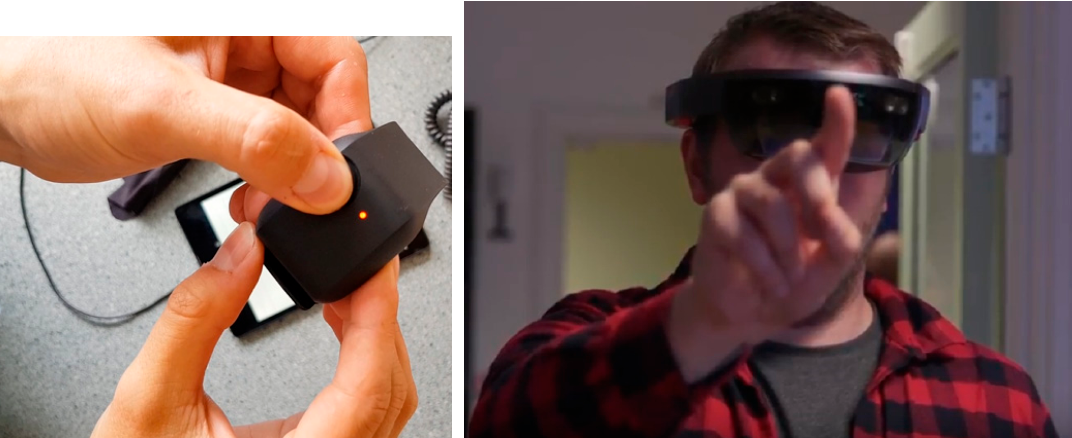
Figure 5. Shows the Empatica E4 heart rate and galvanic skin response (GSR) sensor ( Left ) and augmented reality solution ( Right